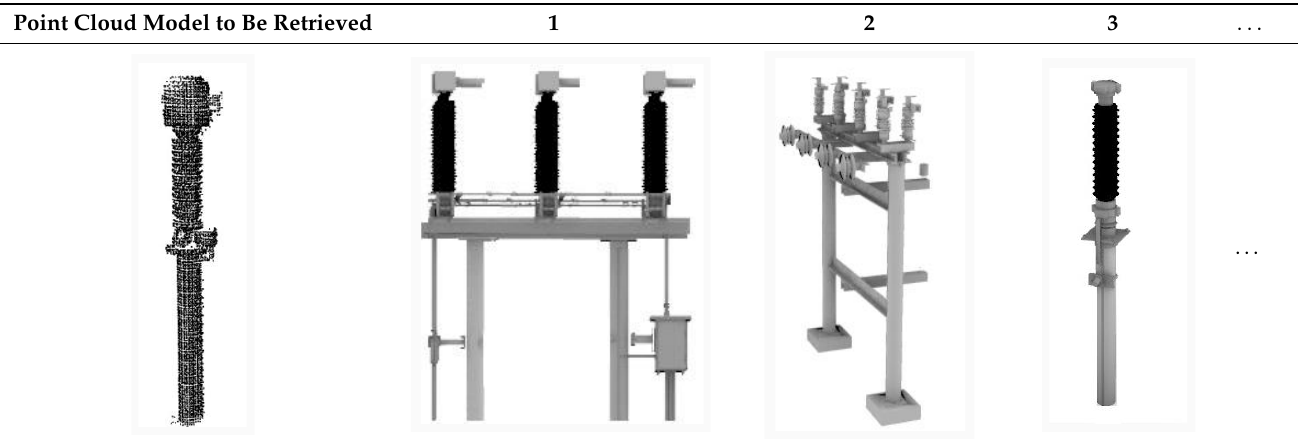
Table 1. Results of the model screening by the bounding sphere. Point Cloud Model to Be Retrieved